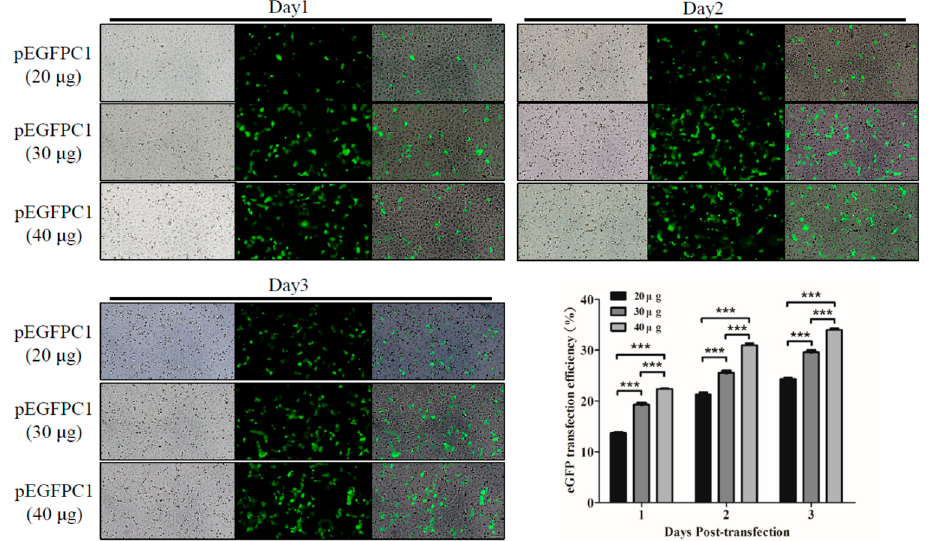
Figure 2. The transfection efficiency in Vero-E6 cells. We transfected the cells with pEGFPC1 at the indicated dosages using lipofectamine 3000. After transfection, we detected the transfection efficiency with GFP expression under fluorescent microscopy. Three independent experiments were performed. *** p < 0.001.